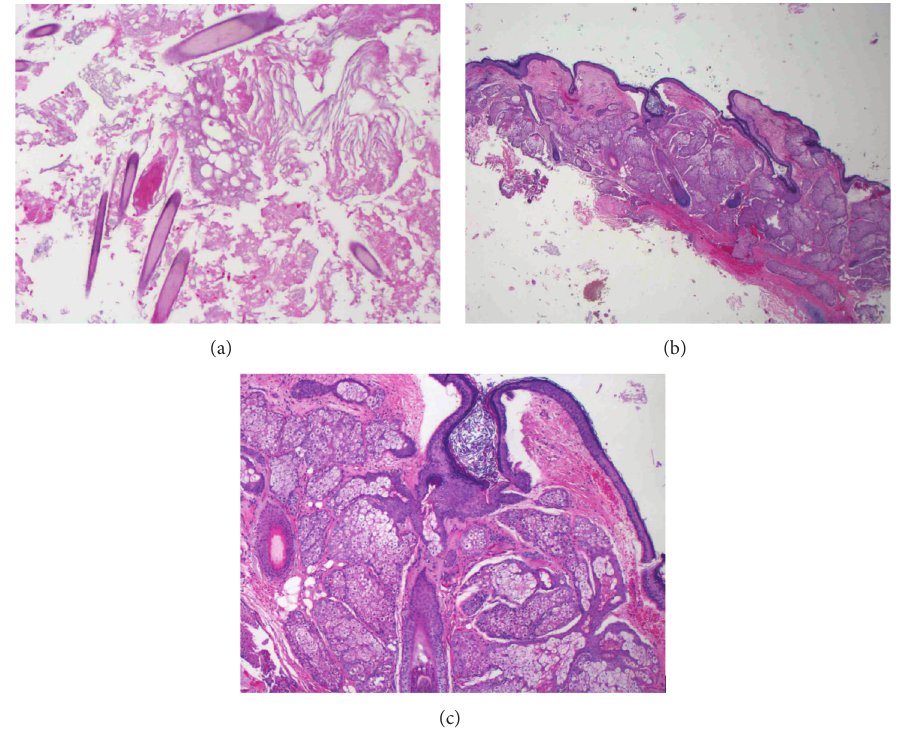
Figure 2: Hematoxylin and eosin (H&E) stained sections of the tumor resection. (a) Cyst contents with hair, keratinous material, and debris. ((b) and (c)) Cyst wall composed of skin and its appendages. Original magnifications: 100x (a), 12.5x (b), and 40x